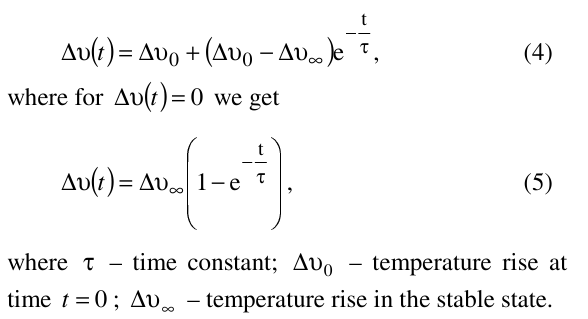
T ) data acquired from temperatures ( 1